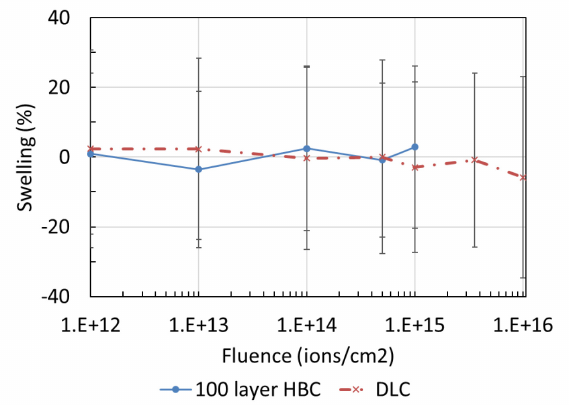
Fig. 6. Swelling of 100 layers HBC and DLC foils irradiated under 0.23 (N/A for DLC foils), 1.4, 10 μAe intensities and the same fluence of 1.40*10 15 ions/cm2.